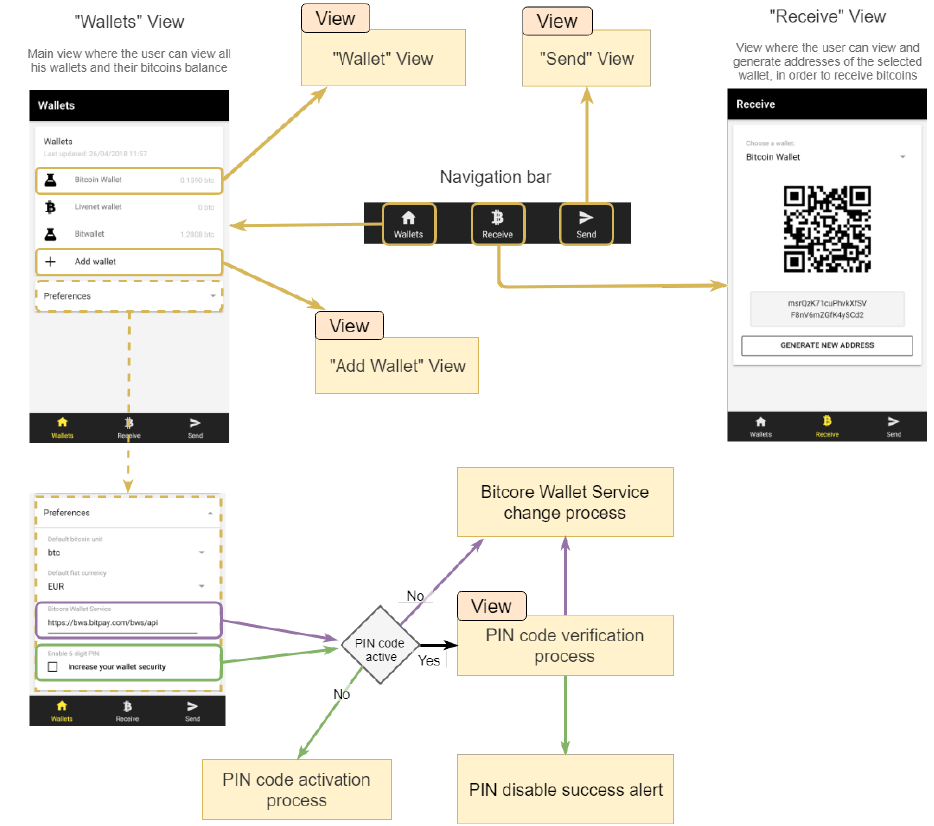
Figure 5. Navigability diagram of the navigation bar and the “Wallets”, “Receive” and “Send” views.